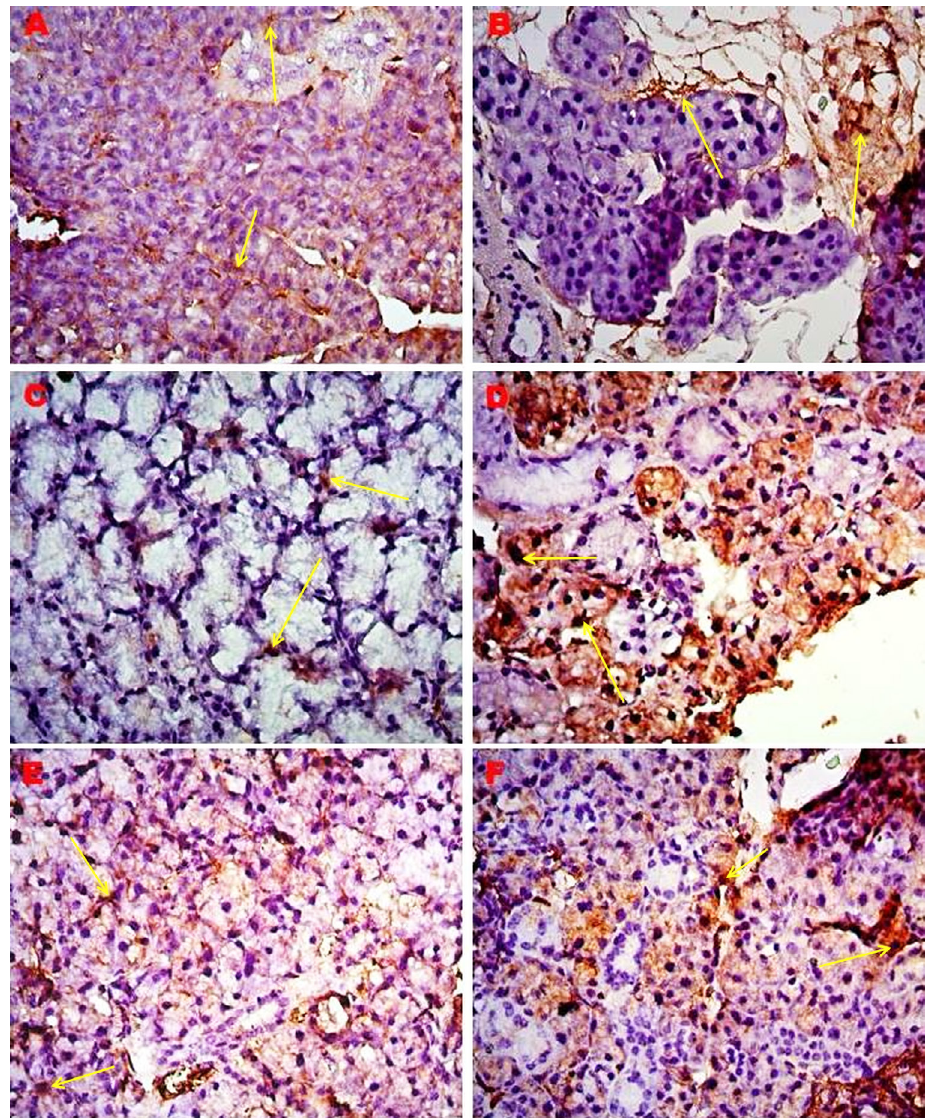
Figure 4- Immunreactivity of MMP-2 protein in major salivary gland, 40X. A) Parotid gland of young mice; B) Parotid gland of old mice; C) Sublingual gland of young mice; D) Sublingual gland of old mice; E) Submandibular gland of young mice; F) Submandibular gland of old mice; *Yellow arrow: Stained cell